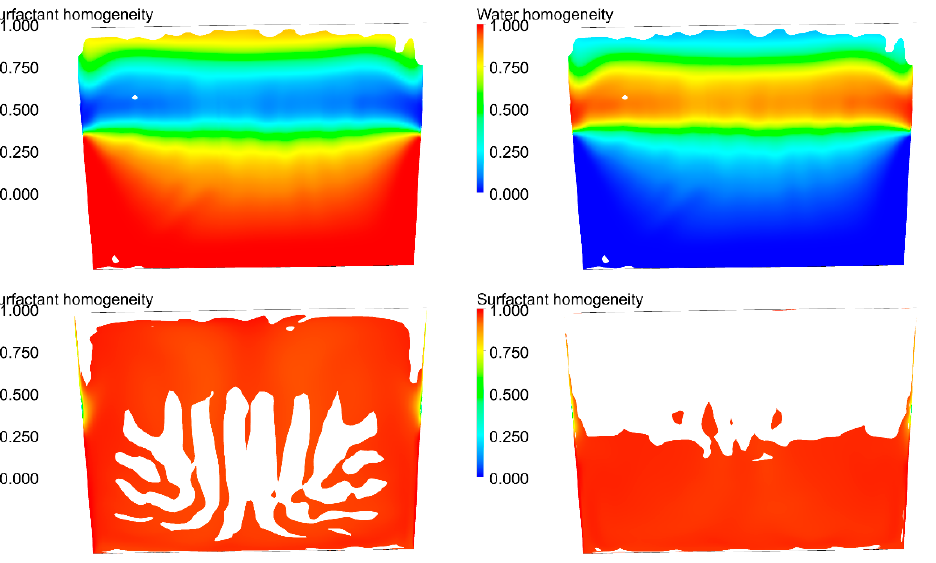
Figure 6. Images of the surfactant homogeneity value after 0.25 s of mixing ( up , left ), the water homogeneity value after 0.25 s of mixing ( up , right ), the surfactant homogeneity value after 3.75 s of mixing ( below , left ) and the surfactant homogeneity value after 7.50 s of mixing. Table 3. Scenarios table. Each scenario is defined by the percentage of each mixture compound, the percentage observed in the table columns from the second to sixth. The following columns show the Homogeneity function for the different times in